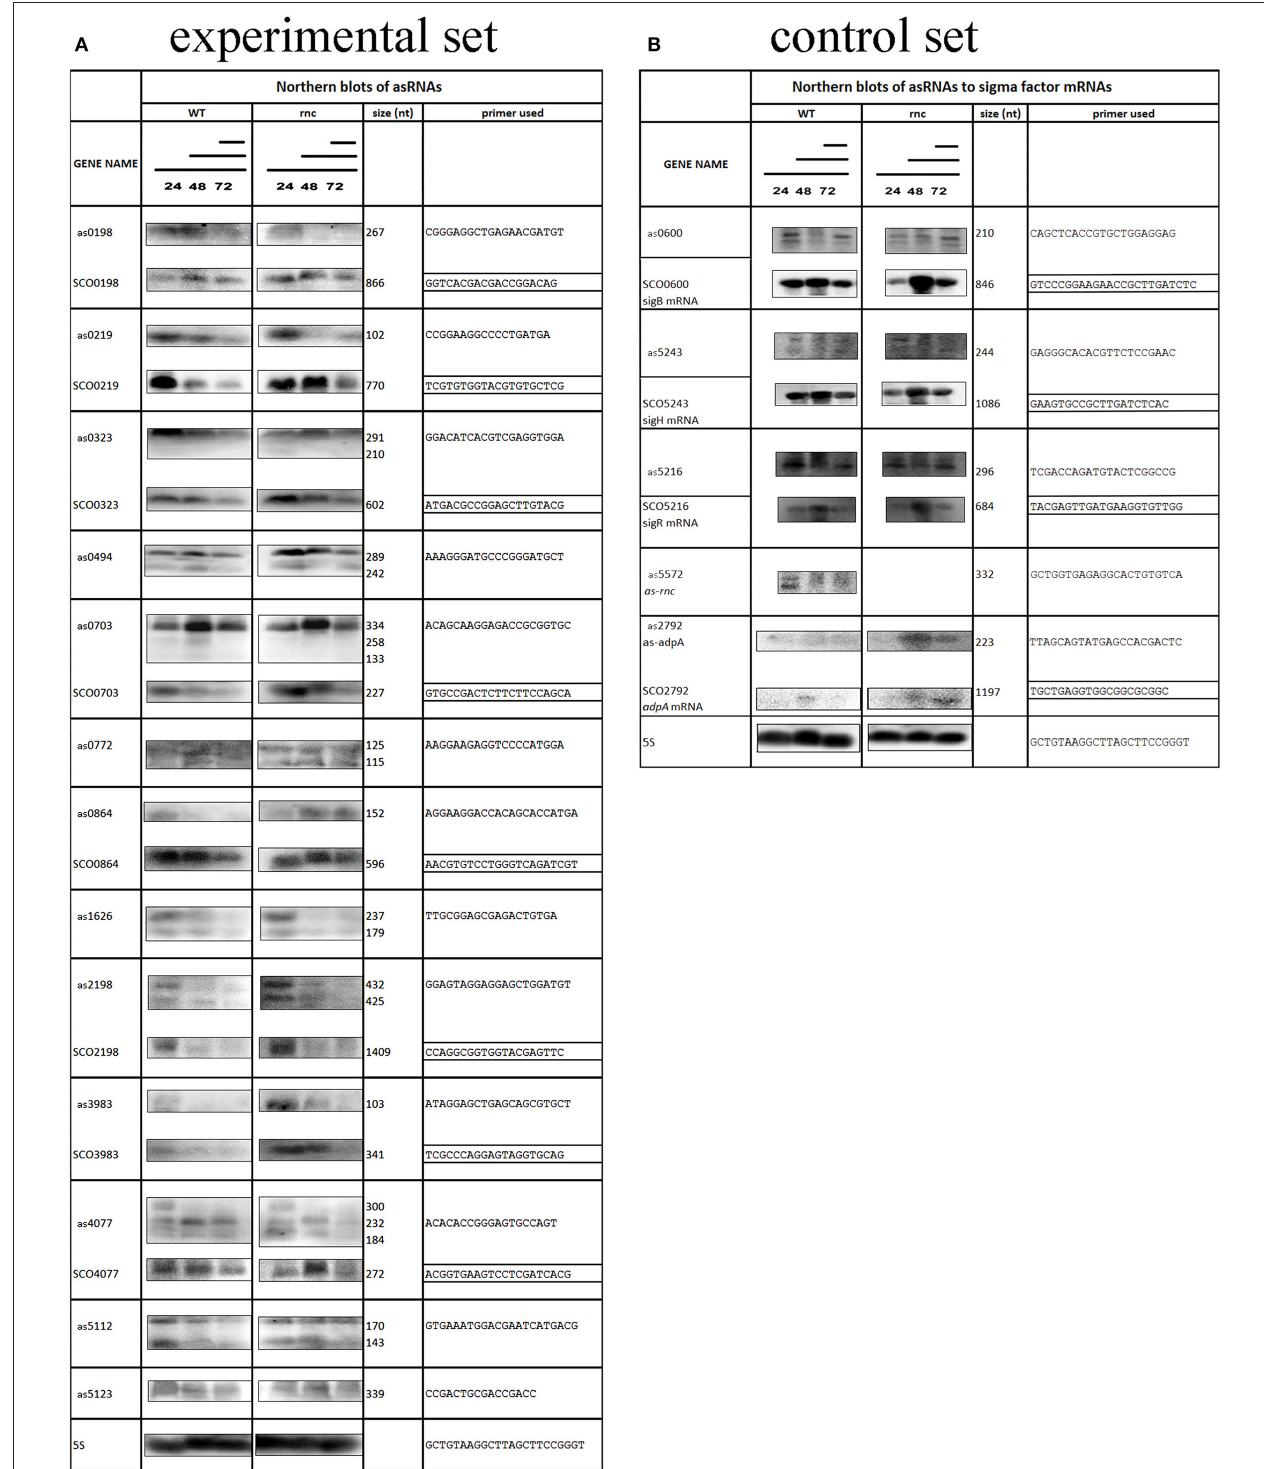
FIGURE 2 | Differential expression analyses of novel asRNAs and their target mRNAs in WT and rnc strains. Three black lines (from long to short) represent RNA samples from vegetative mycelium (24h), aerial mycelium (48h), and spores (72h), respectively. To enable comparison of the expression profiles, all asRNA-mRNA pairs from both WT and rnc strains were analyzed on the same blot. Sizes of the products well corresponded to those obtained by RACE. Primers used are shown on the right. The 5S loading control is included below. The signal quantification is presented in Table S2 . (A) Experimental set; (B) Control set; (see text for details).